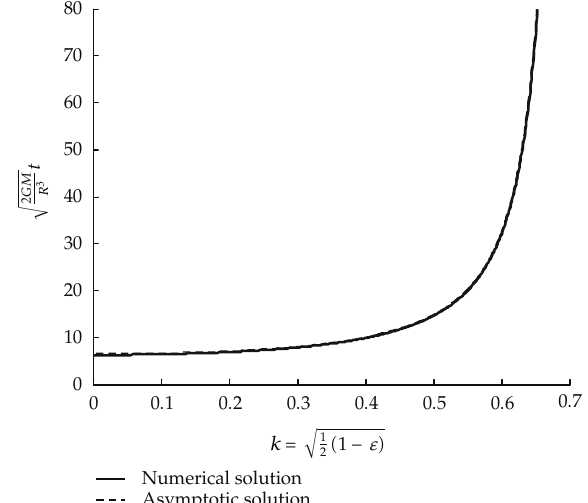
Figure 7: The period of the orbit as a function of the parameter k .